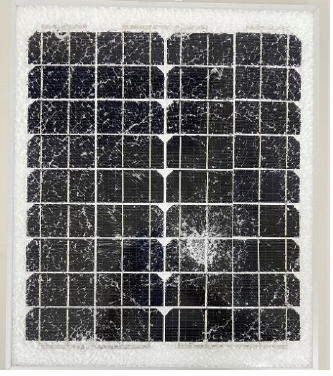
Figure 5. Severe breakage of the PV module.